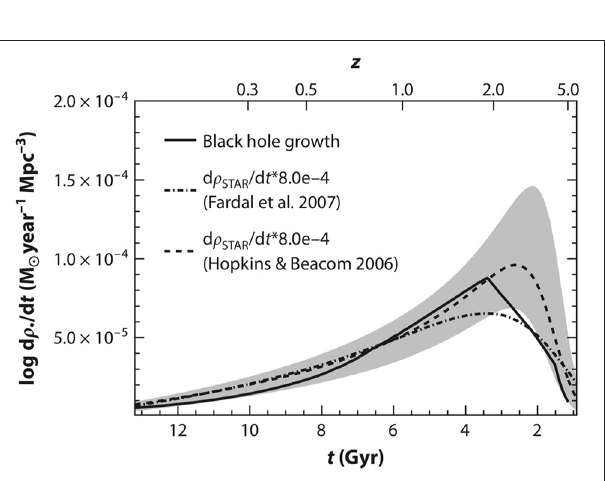
FIGURE 4 | The history of the BH growth compared with that of stellar mass growth (Credit to Heckman and Best, 2014, their Figure 1).